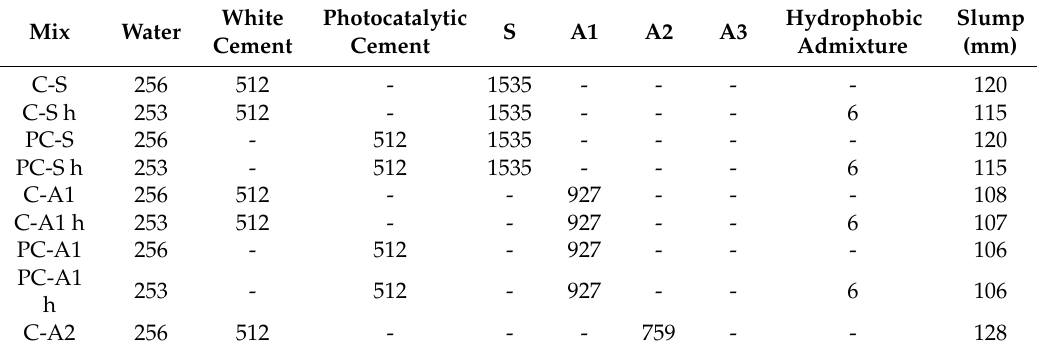
Table 2. Mix proportions (kg/m 3 ) and workability of mortars.